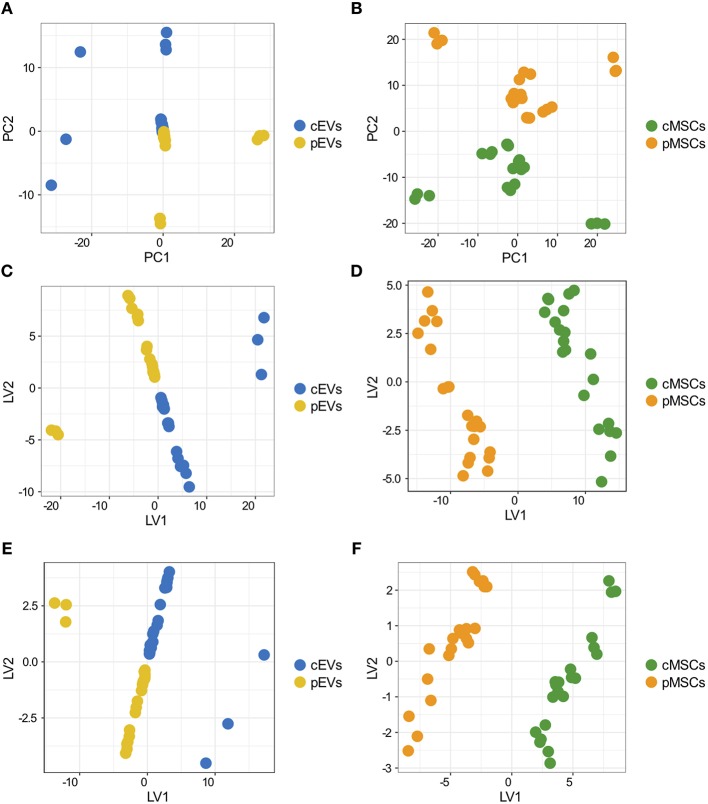
Overall variation of differentially expresses proteins in MSCs and EVs following inflammatory priming and PLS-DA. Score plot of the first two PCs calculated after the application of PCA to EVs (A) and MSCs (B). Score plot of the first two LVs calculated after the application of PLS-DA to the 181 proteins selected by Ranking-PCA on the EVs dataset (C) and on the first 200 proteins selected by Ranking-PCA on the MSCs dataset (D). Score plot of the first two LVs calculated after the application of PLS-DA to the 55 proteins selected by univariate statistics on the EVs dataset (E) and on the 39 proteins selected by univariate statistics on the MSCs dataset (F).